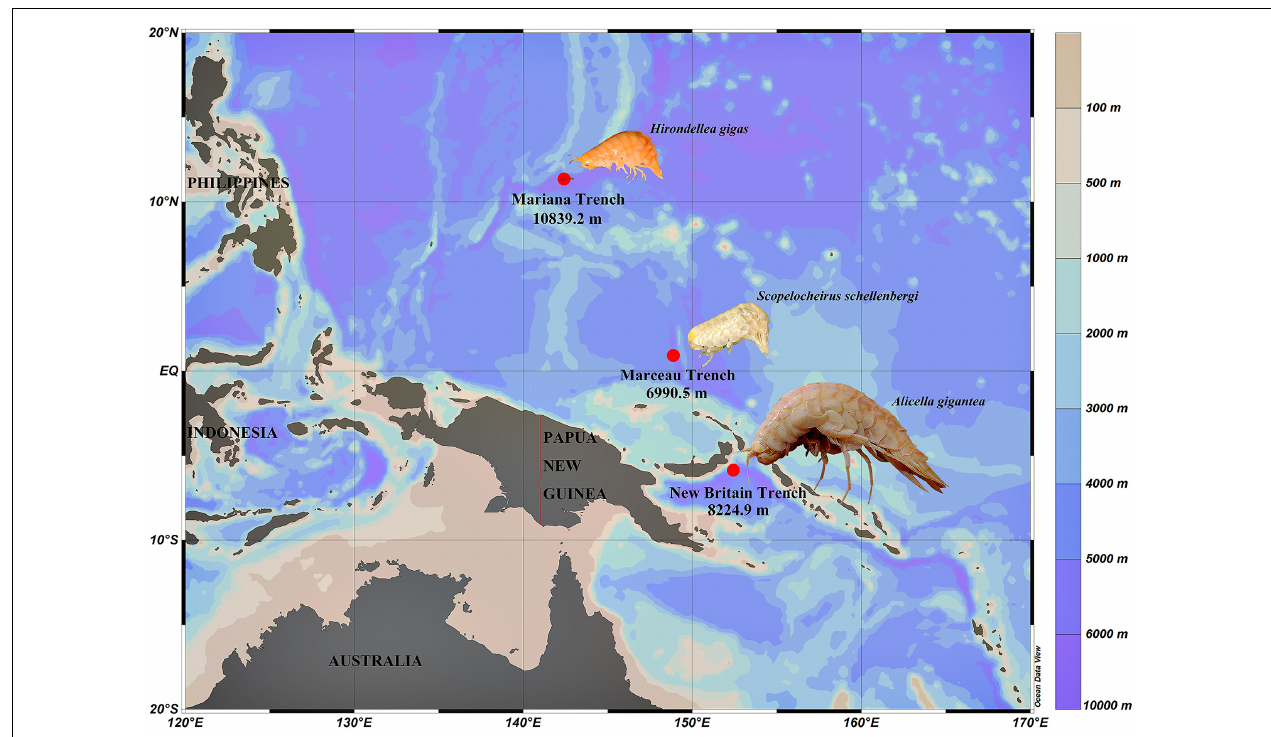
FIGURE 1 | Sampling sites of three amphipods used in this study. H. gigas individuals were from the Mariana Trench (10,839.2 m). S. schellenbergi individuals were from Marceau Trench (6,990.5 m). A. gigantea individuals were from New Britain Trench (8,224.9 m). Color bar indicates different water depths.